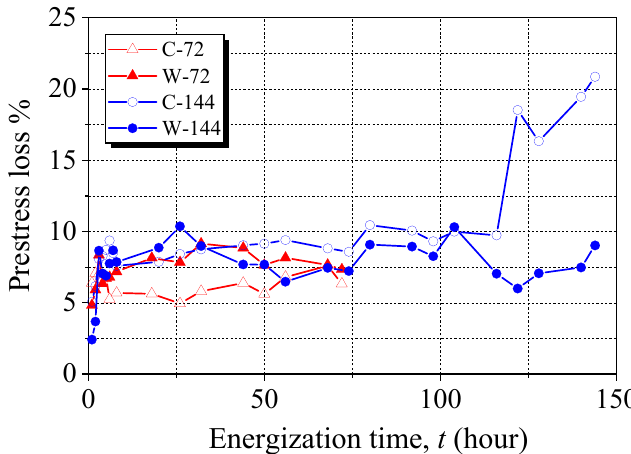
Figure 6. Prestress loss of anchored CFRP laminates during accelerated corrosion.